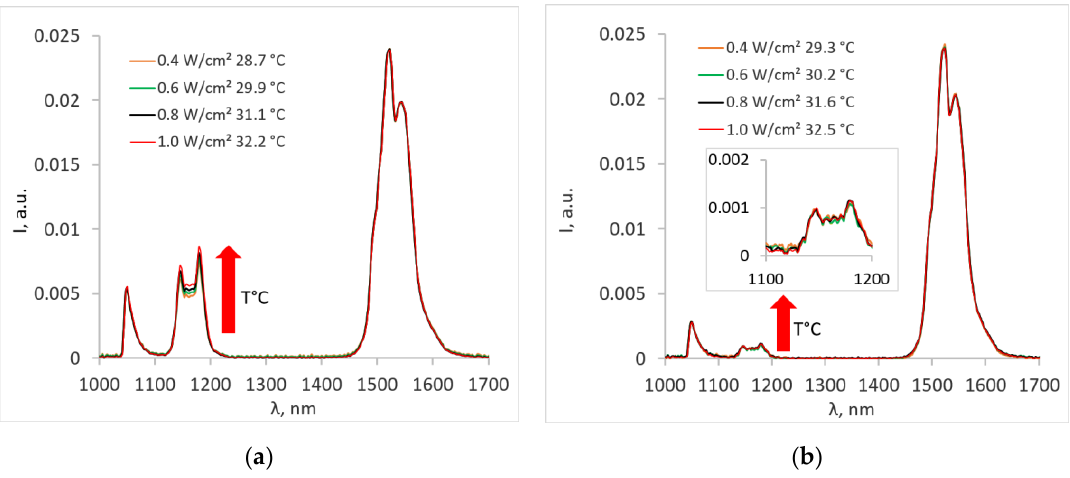
Figure 4. The influence of pump power density and, consequently, the temperature on the emission spectra of nanoparticles in powder: ( a ) core-shell and ( b ) core.